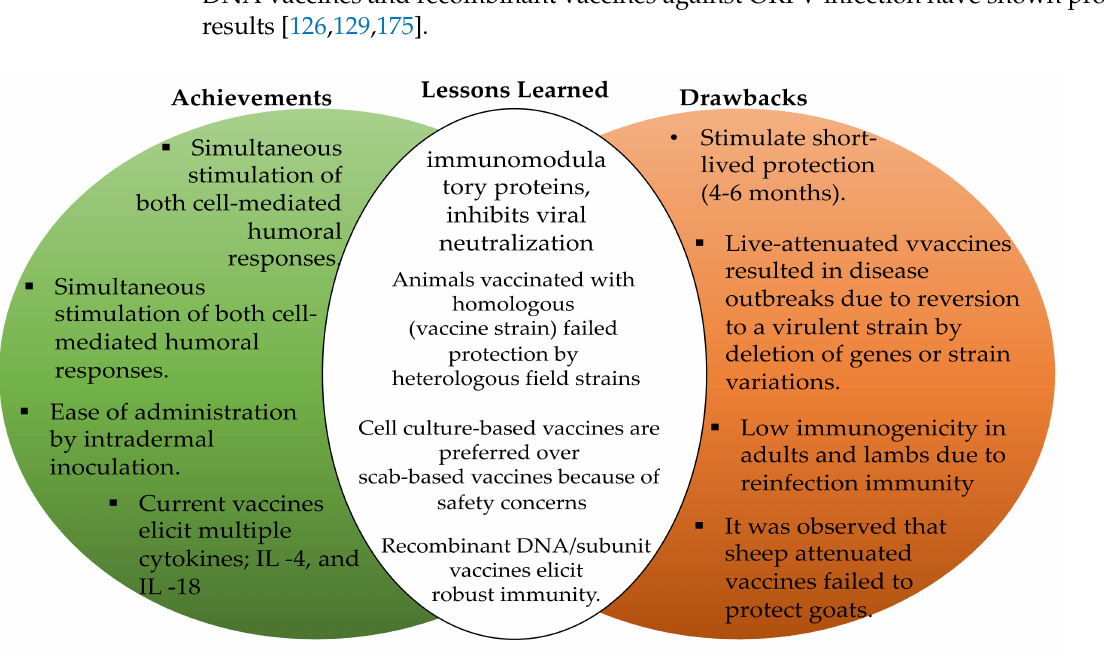
Figure 3. Vein diagram of the overlap of advantages, leasons learned and disadvantages of the immune response elicited by existing vaccine platforms against Orf virus